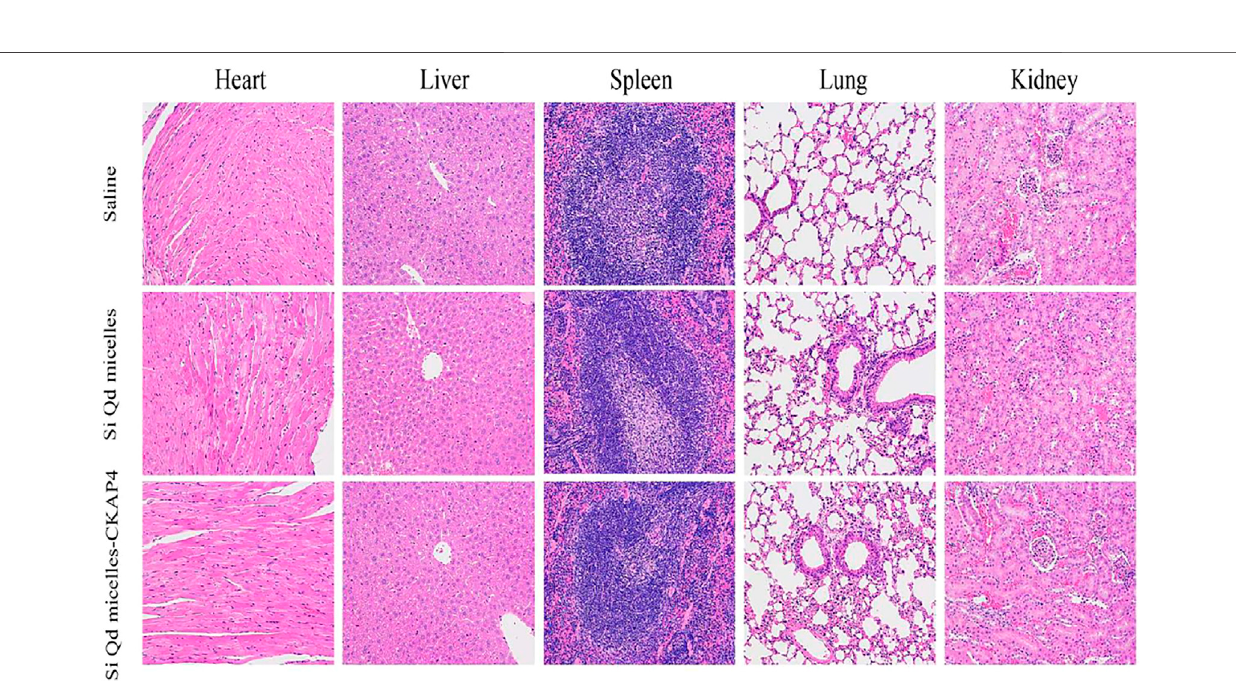
FIGURE 5 | H&E staining images of the heart, liver, spleen, lungs, and kidneys in tumor-bearing mice injected with saline, Si QD micelles (Si: 4 mg/kg), and Si QD micelles-CKAP4 (Si: 4 mg/kg) for 24 h (magni fi cation: × 200). Reproduced from Huang et al. (2021) under creative commons CC BY license. Copyright © 2021 Huang et